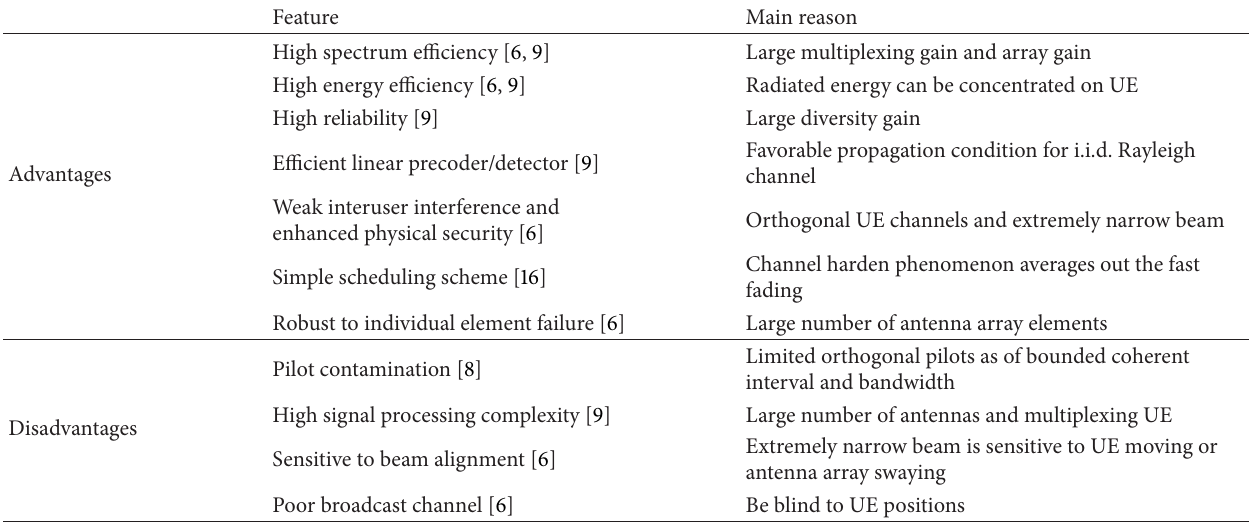
Table 1: Features of massive